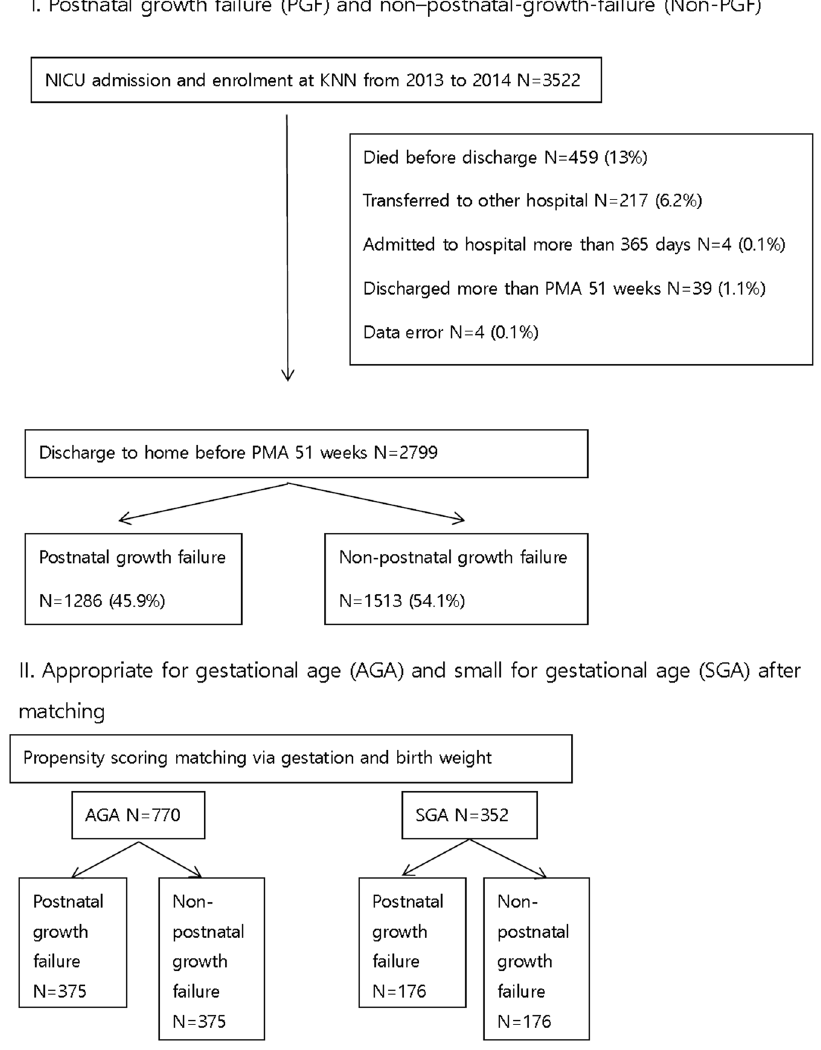
Figure 1. Flow Chart of study